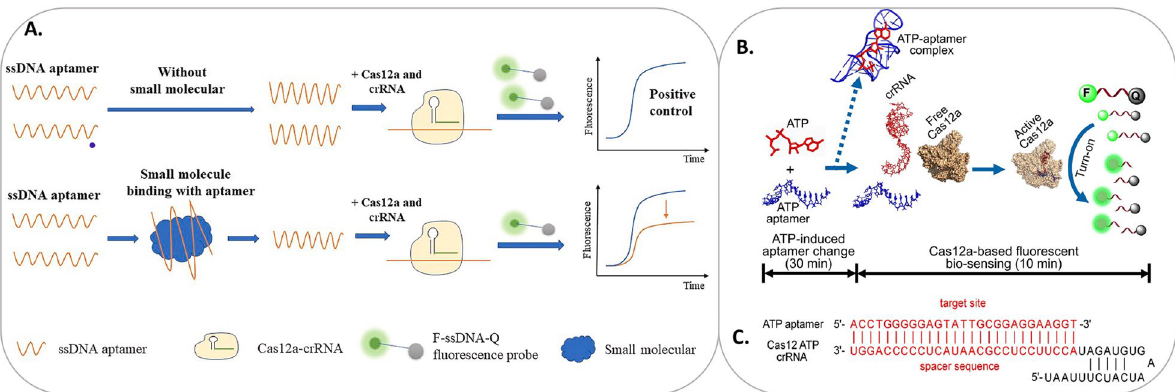
Fig. 6 The small molecule diagnostics. A Generalized schematic of the molecular radar strategy for small molecules diagnostics (Figure from Niu et al., Biosensors and Bioelectronics 183 (2021) 113196; Copyright by Elsevier, used with permission). B Proposed CRISPR-Cas12a biosensor for ATP detection; C The schematic of target ssDNA as well as crRNA used; the target site is highlighted in red (Figure from Peng et al., Sensors & Actuators: B. Chemical 320 (2020) 1281642; Copyright by Elsevier, used with permission)